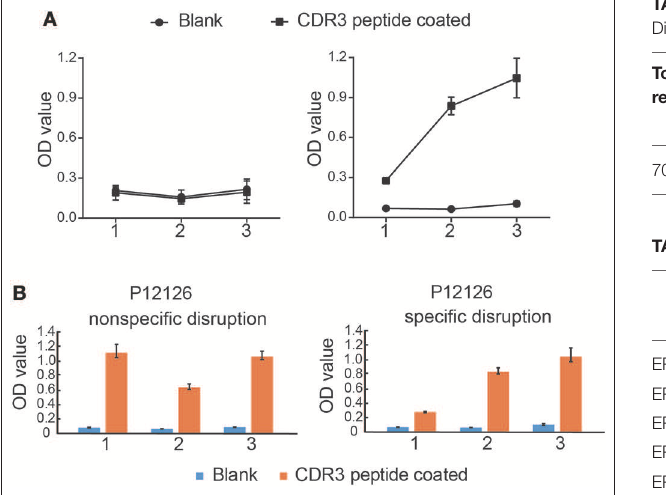
FIGURE 4 | Mtb -related antigen epitopes bound to CDR3 δ peptides screened using the Ph.D TM -12 Phage Display Peptide Library. (A) The binding curve of phage elutions to CDR3 δ probes by ELISA. The left panel shows the binding of non-specifically eluted phage to the CDR3 δ probes, and the right panel shows the binding of the specifically eluted phage to the CDR3 δ probes. 1, 2, and 3 indicate the screening rounds. (B) Histograms of the binding between phage elutions to CDR3 δ probes by ELISA. Data represent the mean ± SEM.